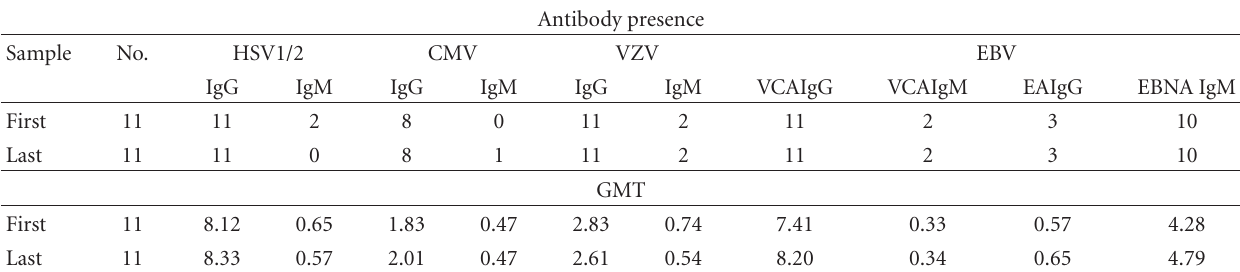
Table 7: Presence and geometric mean titres of antibodies against human herpesviruses in CML patients prior to the start of the therapy and after achieiving hematological and/or complete cytogenetic remission. Antibody presence